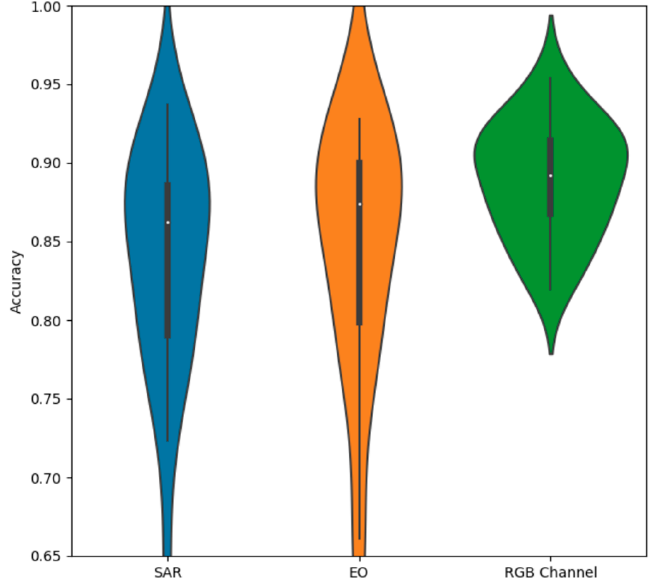
Figure 24. Accuracy distribution of RGB channel fusion vs. SAR and